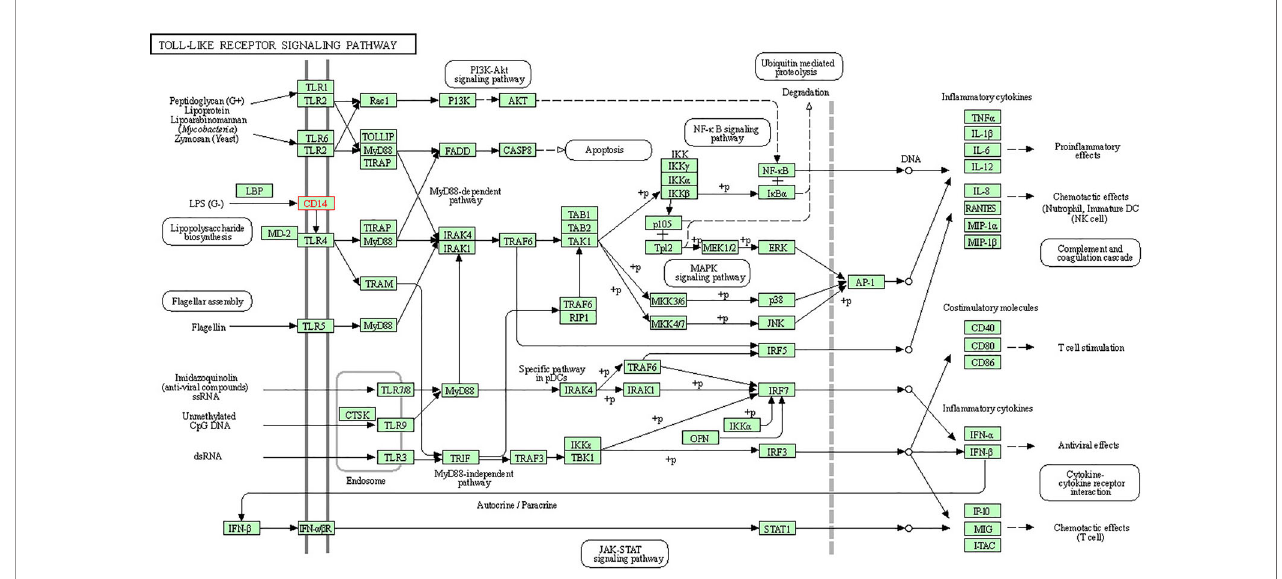
FIGURE 7 | KEGG analysis depicting biochemical pathway involved in CD14 molecules.